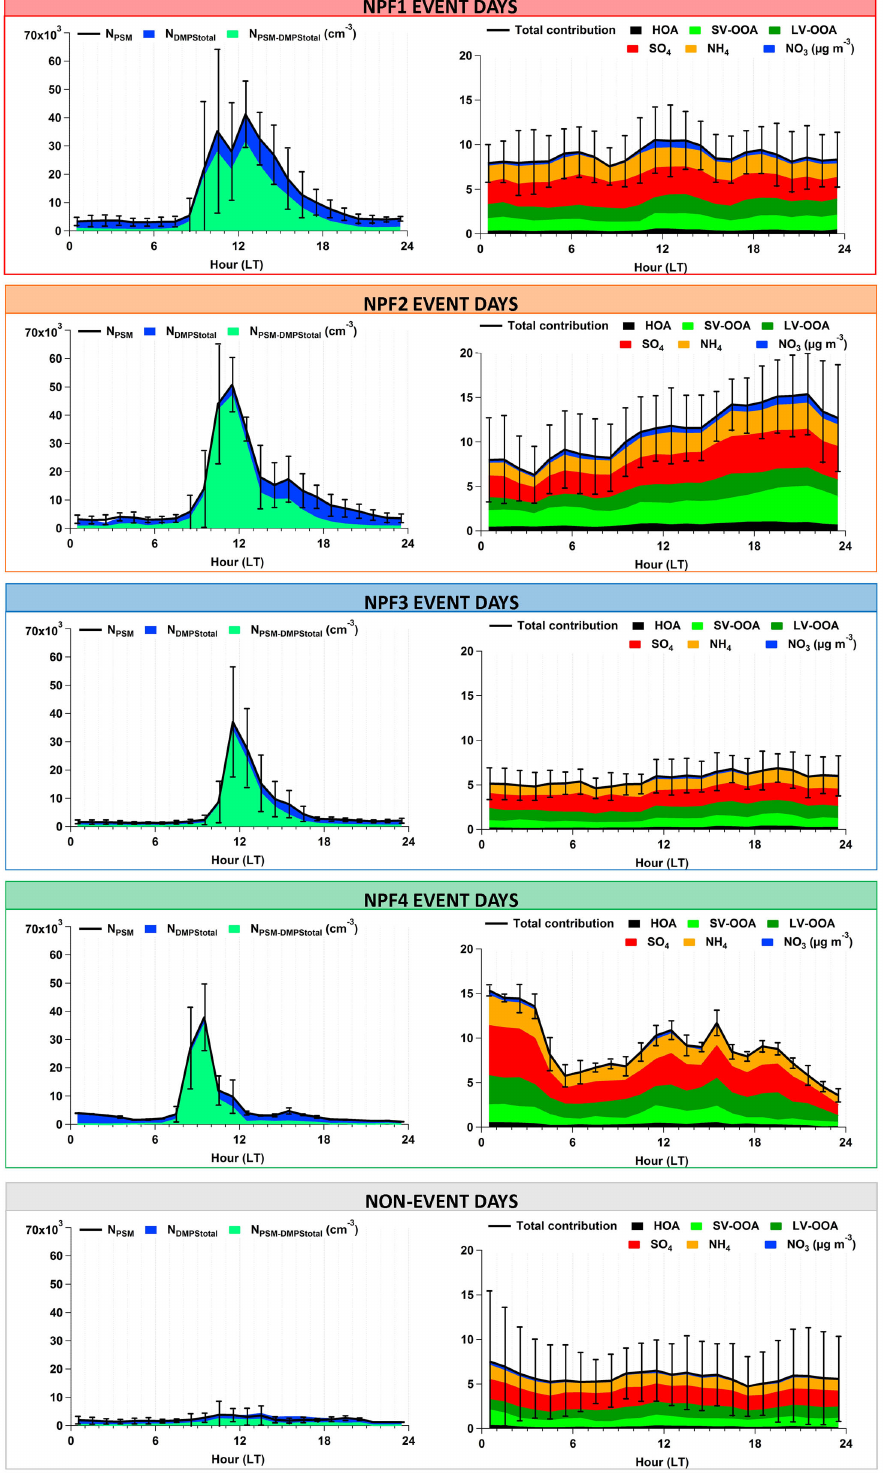
Figure 9. Diel variation of particle number N PSM and N DMPS and accumulated diel variations of PM 1 contribution for NPF event days (NPF1–NPF4) and non-event days. Diel variations are represented by daily mean values associated with standard deviation when several days were combined. Time is given in local time (UTC +